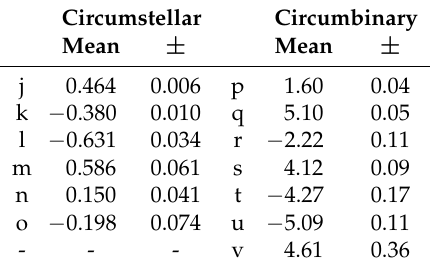
Table 2. Orbital stability fit parameters and their respective uncertainties as given in [26] for prograde circumstellar and circumbinary motion of a massless test-planet. Circumstellar Circumbinary